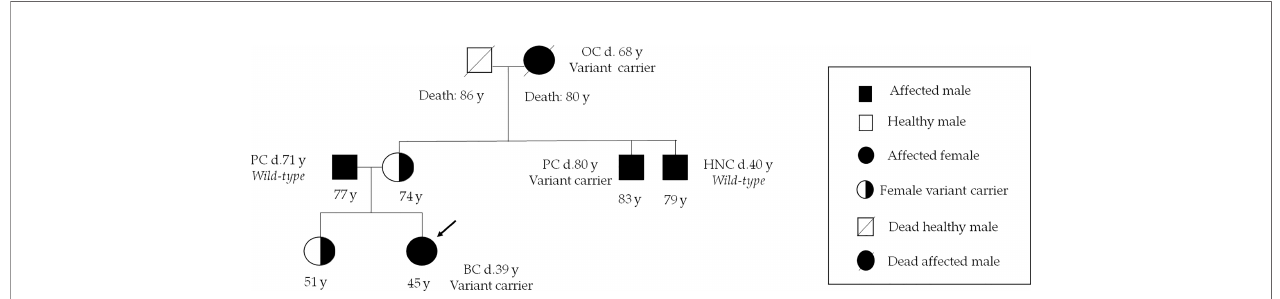
FIGURE 3 | Family pedigree of the c.3367G>T carrier patient. Index case is indicated by an arrow. Numbers under symbols show the age of the patient and relatives. Instead, the age at diagnosis for the affected individuals is indicated by letter “ d ” . BC, breast cancer; HNC, head and neck cancer; OC, ovarian cancer; PC, prostate cancer.